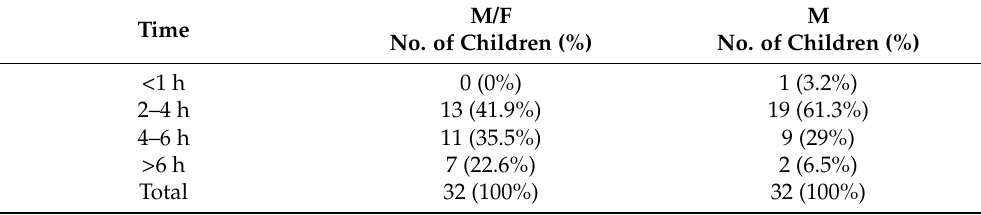
Table 3. The amount of time needed until the first meal after sedation for children in both